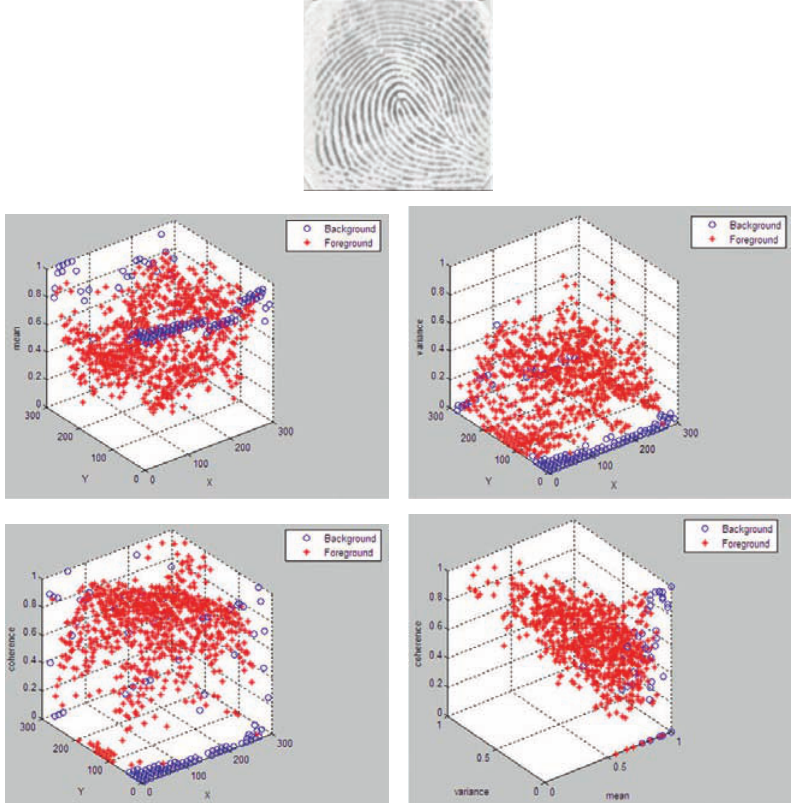
Figure 2. Spatial distribution of fingerprint features. Upper row: image 1_4 of DB1-a FVC2000. Middle row: Spatial distribution of mean (left) and variance (right), Lower row: coherence (left) and relationship among mean, variance and coherence